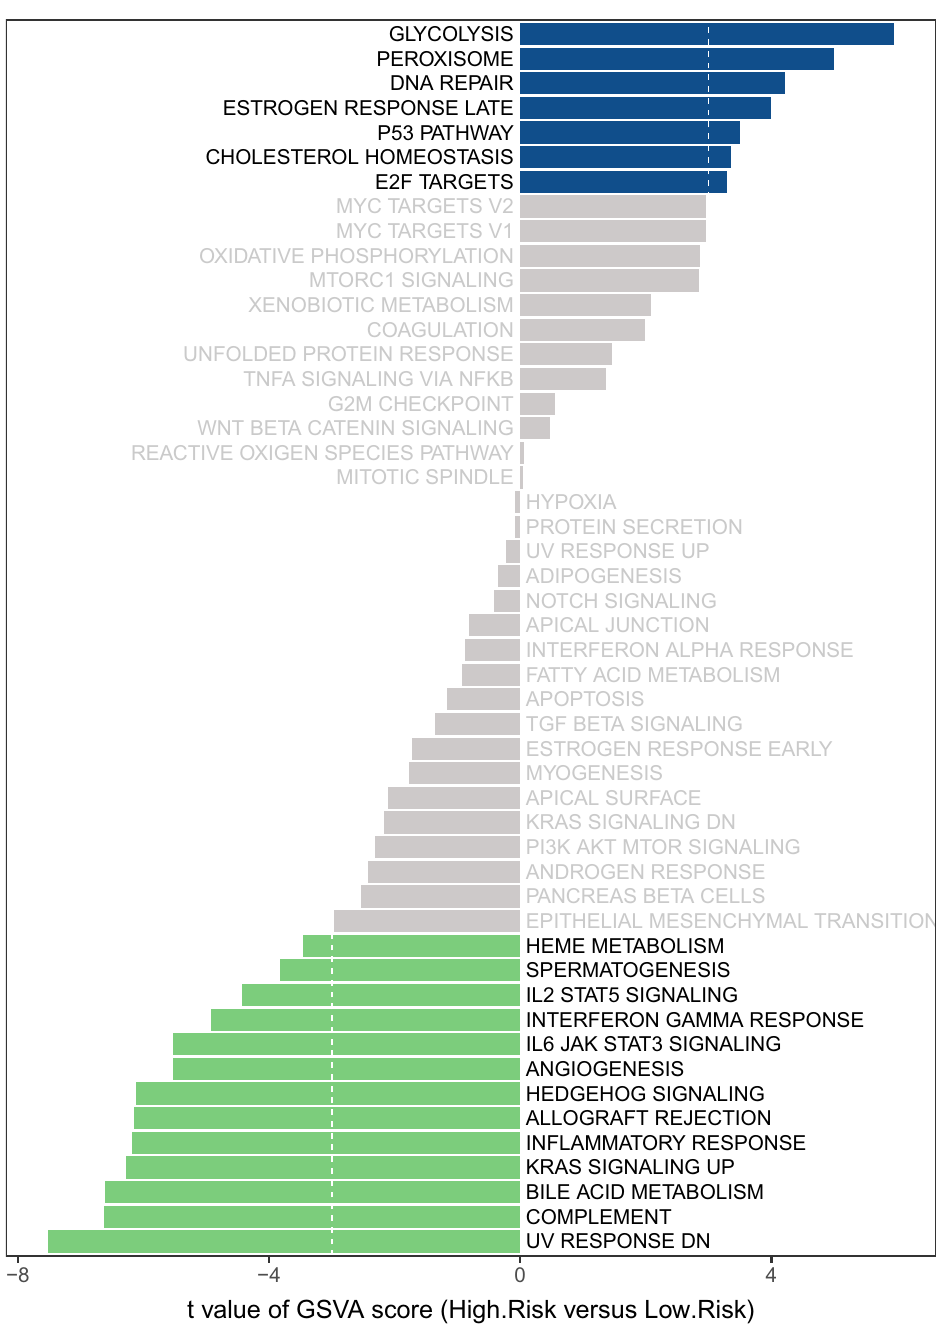
Figure 5. A gene set variation analysis with the hallmark gene set. Differences in pathway activities scored by GSVA between high- and low-risk patients. T values are shown from a linear model. We set |t|> 3 as a cutoff value. The midnight blue column indicates activated hallmark gene sets in high-risk patients, and the green column indicates activated hallmark gene sets in low-risk